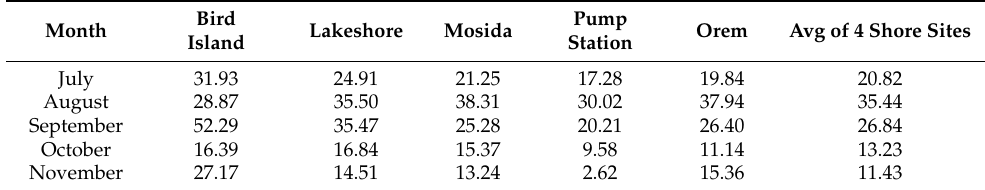
Table 5. Monthly DIN deposition data comparing results from the lake interior sampling location (Bird Island) to data from lake shore sample locations. Except for August, Bird Island, the lake interior site, had higher AD rates than the average of the four shoreline sites. All data represent deposition rates in mg/m 2